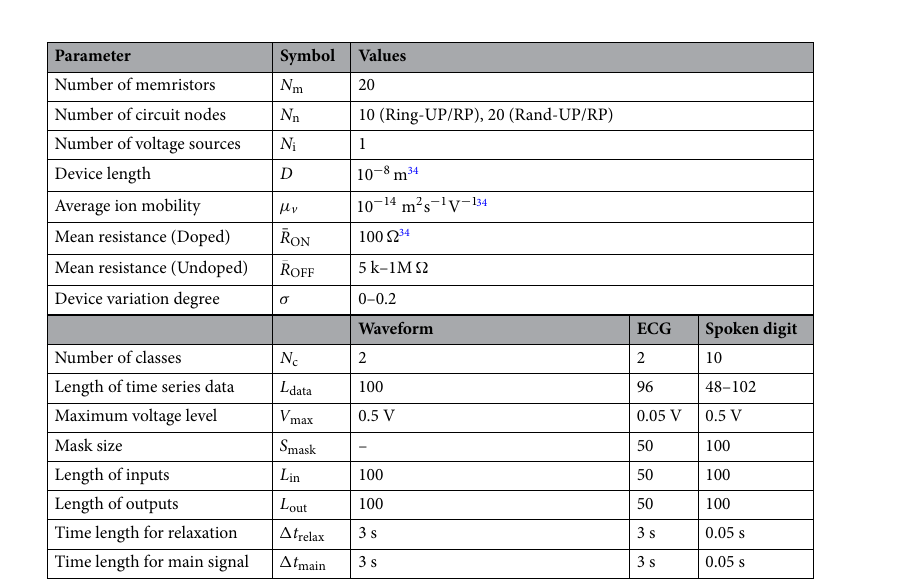
Table 1. List of system parameters and their